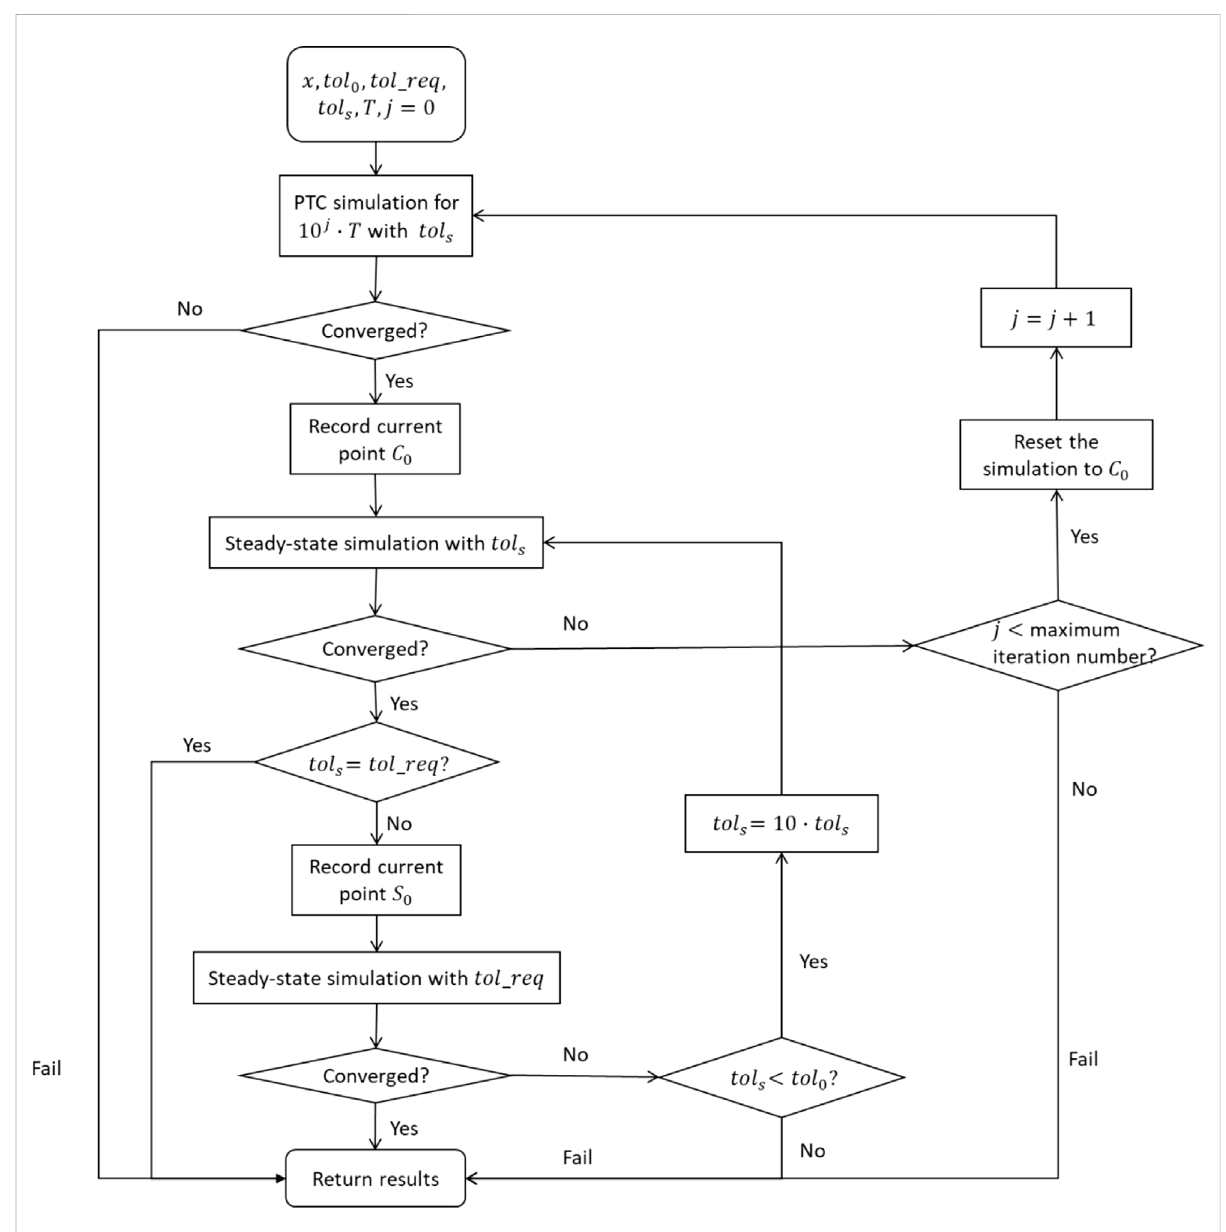
FIGURE 2 Tolerances relaxation integration